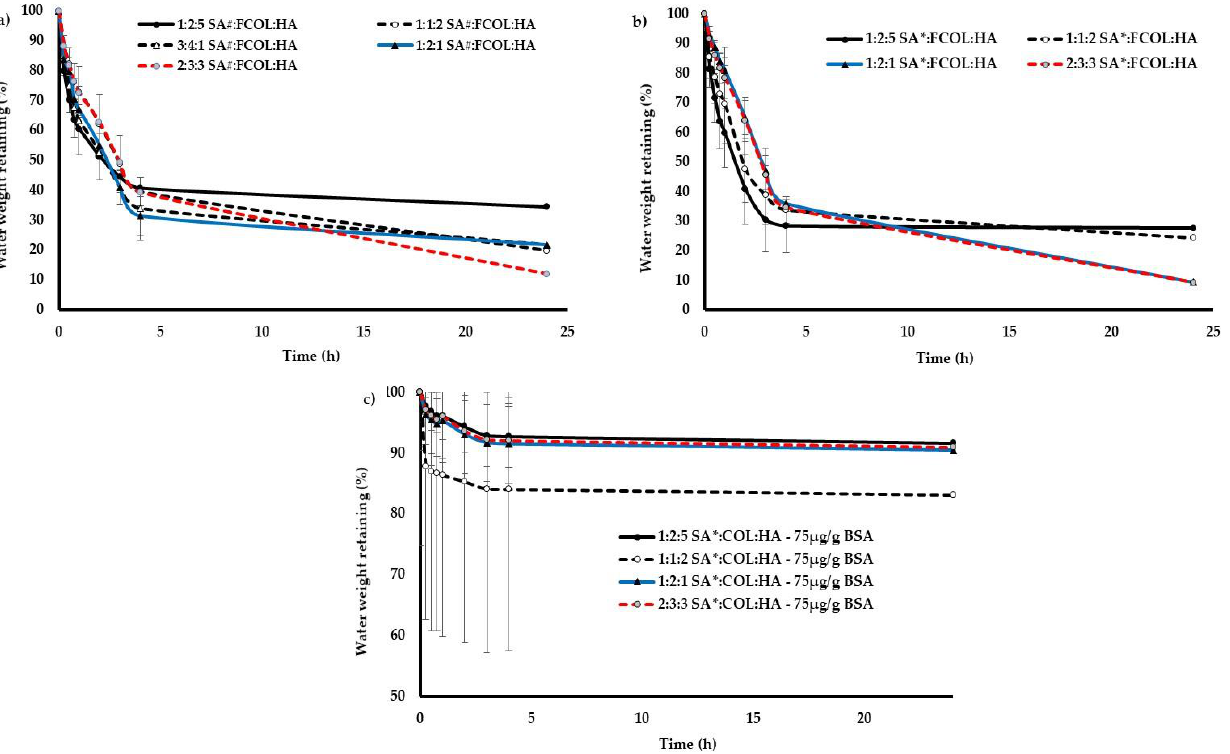
Figure 8. EWL from ( a ) SA#:FCOL:HA ( b ) SA*:FCOL:HA and ( c ) BSA loaded SA*:FCOL:HA